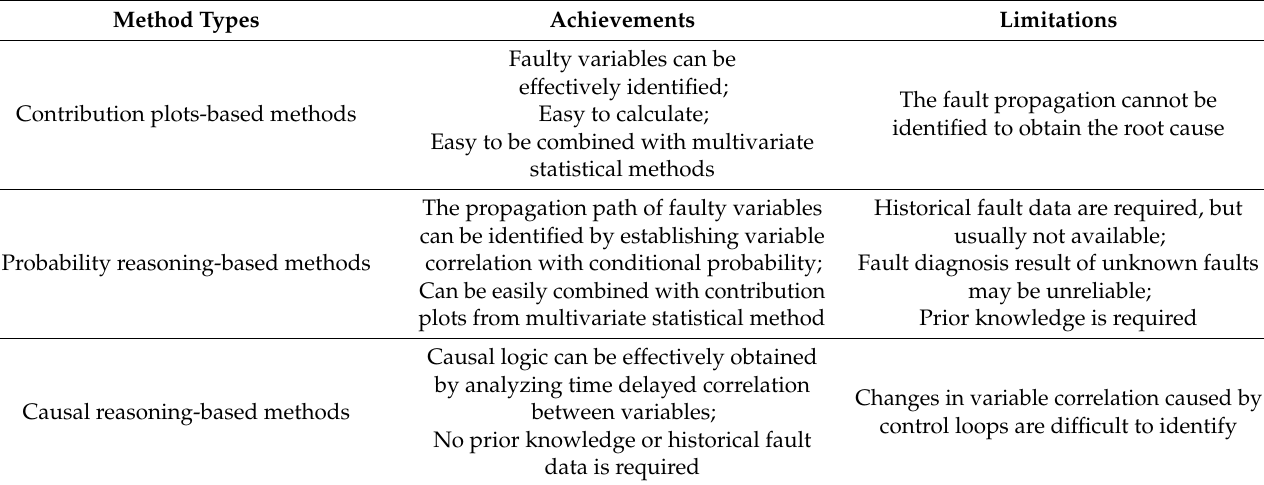
Table 9. Comparative analysis of fault diagnosis